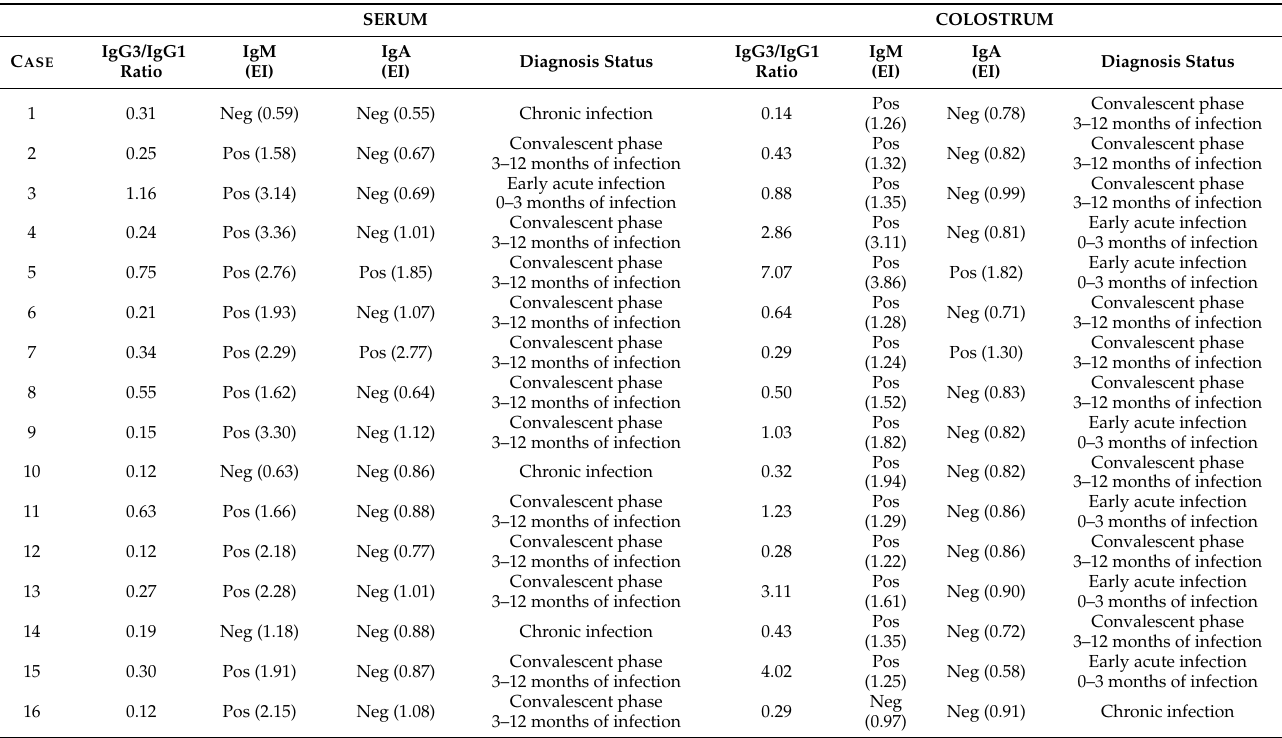
Table 3. Results of IgM and IgA levels in addition to IgG3/IgG1 ratios in serum and colostrum sam- ples from 16 cases of puerperal women with acute status diagnosis in serum or colostrum samples. SERUM